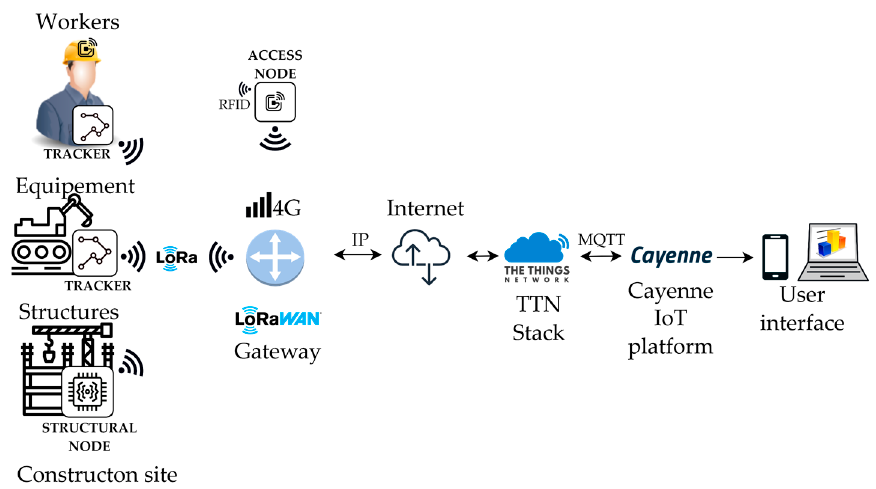
Figure 2. System architecture scheme.